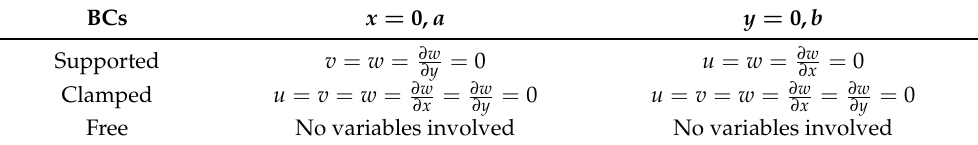
Table 2. Essential boundary conditions